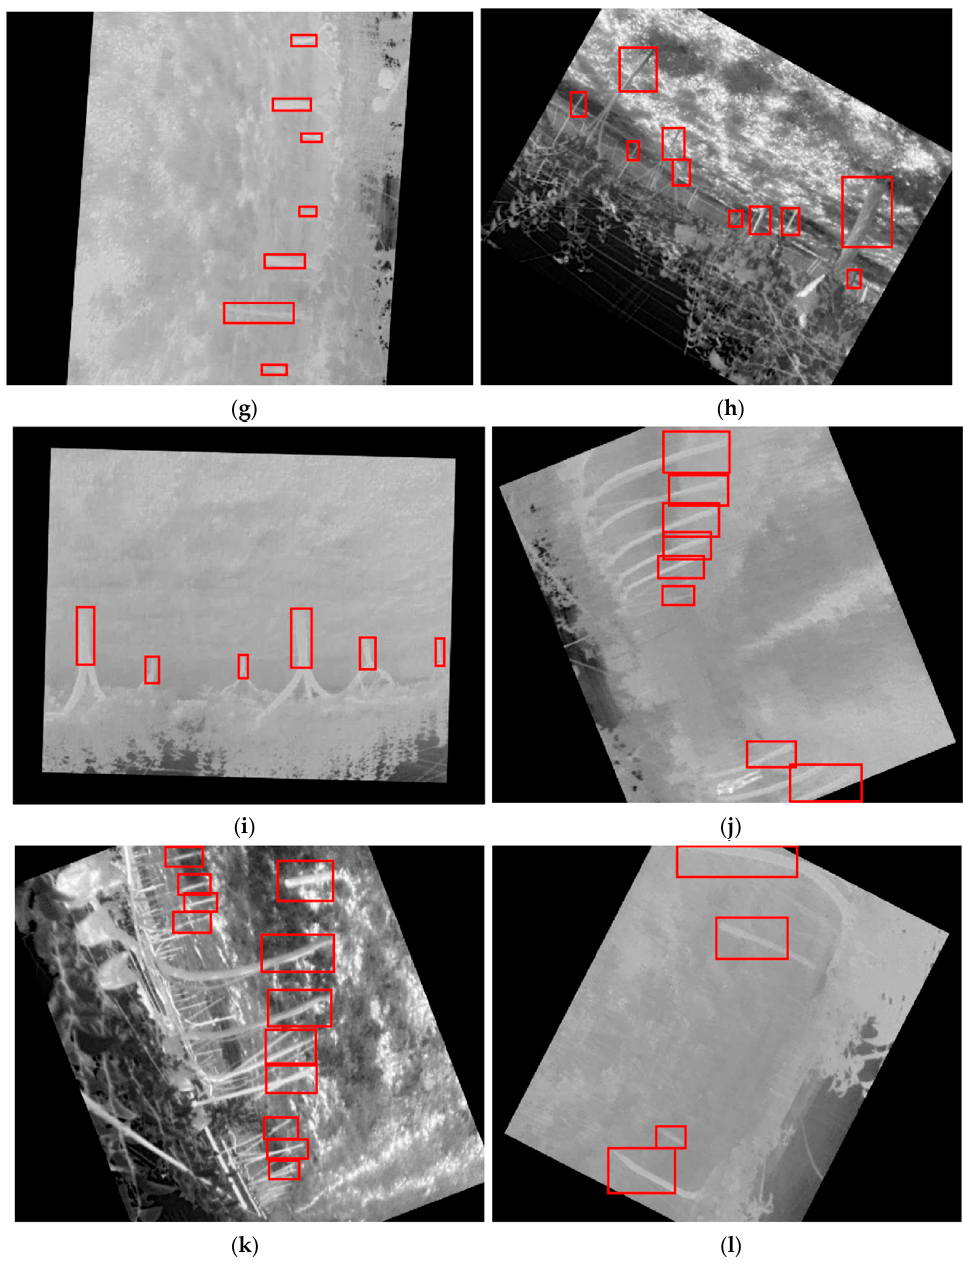
Figure 10. Validation results of Faster R-CNN. ( a – f ) Original images. ( g – l ) Randomly flipped and rotated images.